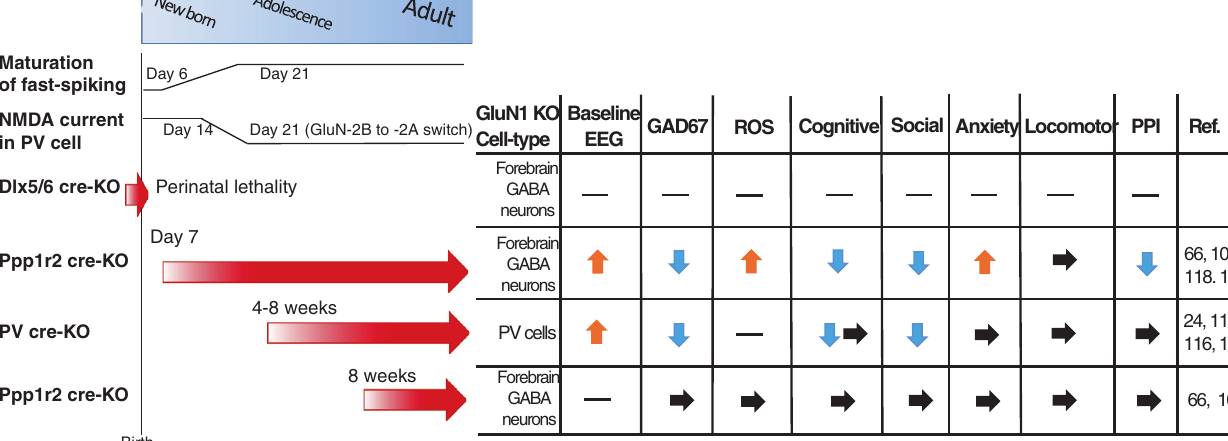
Fig. 2 Summary of schizophrenia-related phenotypes in various GluN1 mutant mice, in which GluN1 knockout is targeted to GABA neurons. GluN1 deletion during the embryonic stage in migrating forebrain Dlx5/6-positive GABAergic cells lead to lethality(Dlx5/6 cre KO). In contrast, GluN1 deletion after postnatal 4 weeks in PV neurons (PV-cre KO) or after adolescence in Ppp1r2-positive GABA neurons (bottom strain) produce less phenotypes compared to the mutant mice that received GluN1 deletion in GABA neurons in early postnatal period (Ppp1r2 cre- KO starting from PND 7). Thus, it appears that early postnatal period, but not during the embryonic stage or after adolescence, is a critical period of GABAergic NMDAR hypofunction leading to schizophrenia. arrow shows the period of knockout occurring in the designated KO cell- type in the cortex. The level of intrinsic property maturation of neocortical fast-spiking neurons largely based on Refs. 68,69. Relative change in synaptic evoked NMDA component estimated from the data in Ref. 22 for hippocampal PV neurons and Ref. 65 for mPFC PV neurons. Hyphen denotes no data. The data of Dlx5/6 cre-KO mice is unpublished. ROS reactive oxygen species. PPI , prepulse inhibition of startle re fl